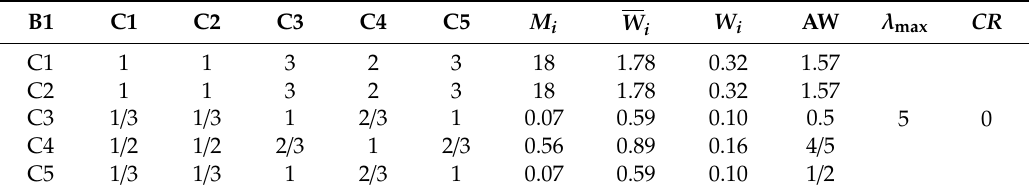
Table 5. Pairwise judgment matrixes of the index layer and their consistency check (evaluation indicators belong to the criterion layer of B1).